Question: What caption would you write for this figure?
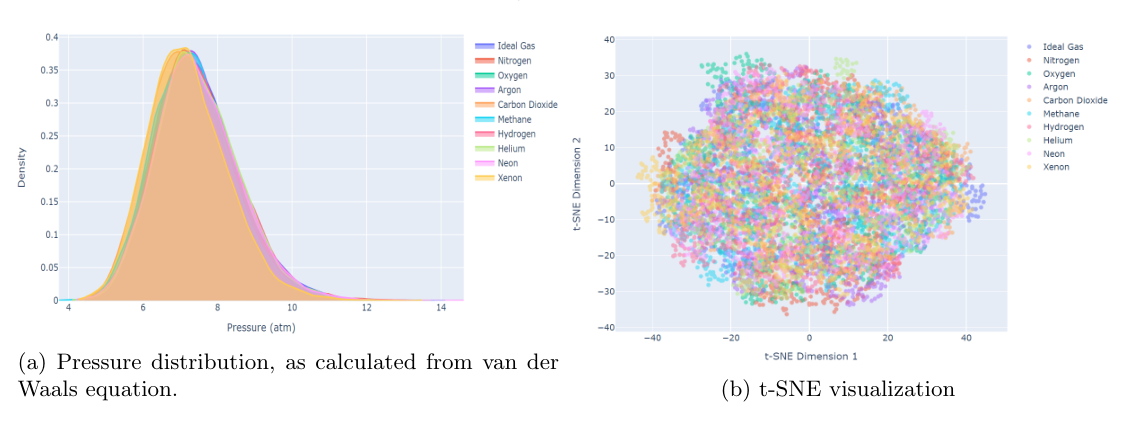
Answer: Pressure distribution and t-SNE plot for the various gases